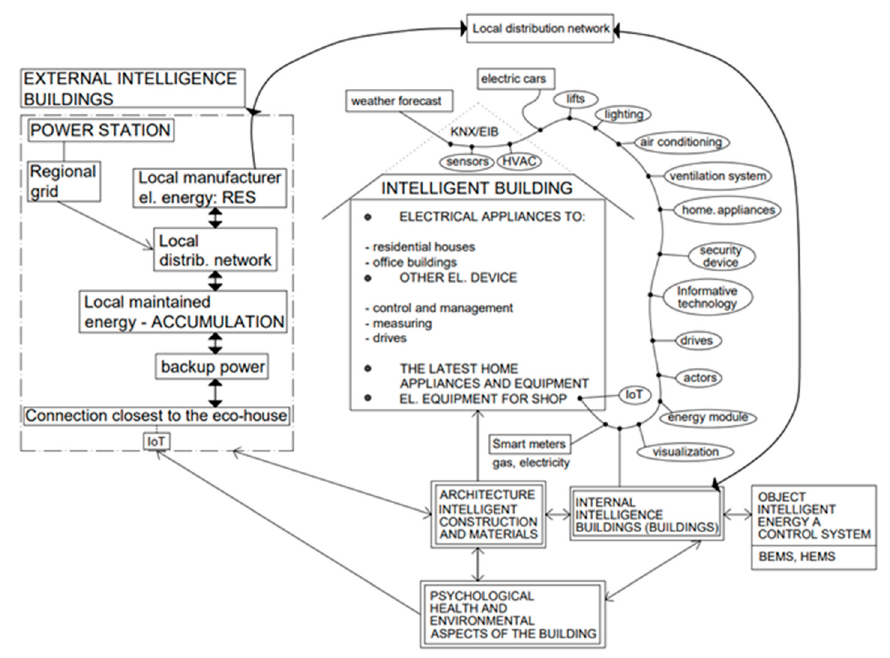
Figure 12. Model Process and Structure of an Intelligent Building.